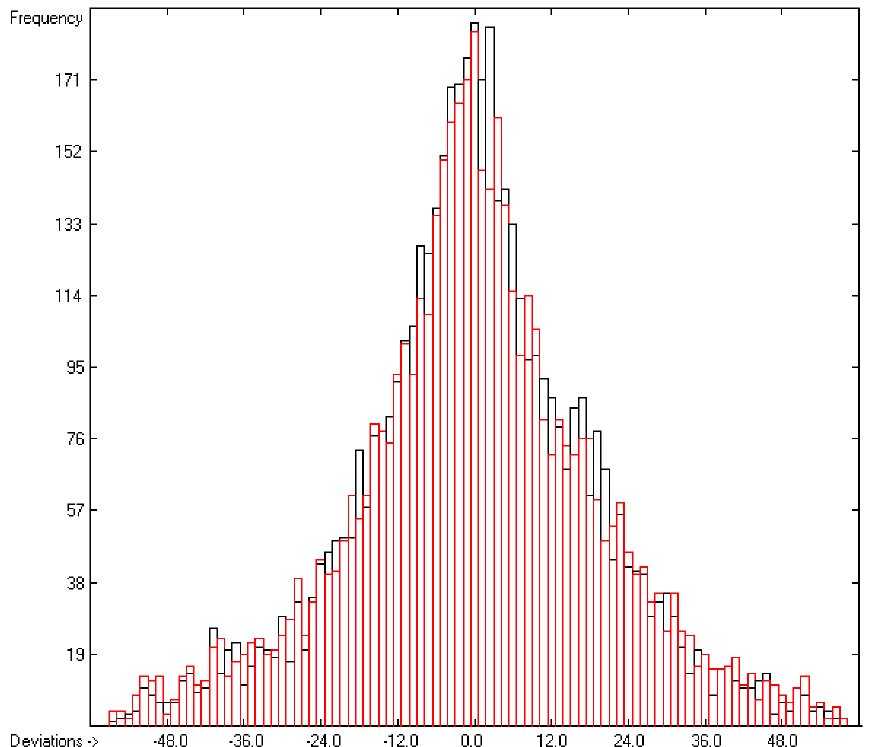
Figure 2. Histogram of the heat-of-combustion data in kJ/mol. Cross-validation data are superpositioned as red bars. ( σ = 18.12; S = 19.16; experimental values range from − 35,100 to − 98.2). The extraordinary accuracy of the predictions allows a deeper analysis of the actual structural state of certain classes of molecules for which alternative structures are possi- ble at standard conditions, in particular as to which prototropic forms are prevailing in amino acids and which tautomeric form is prevalent in compounds that may exist in both hydroxyazo and hydrazone or keto and enol forms. Beyond this, an educated esti- mate as to what the enthalpy difference is between the alternative forms might be possi-